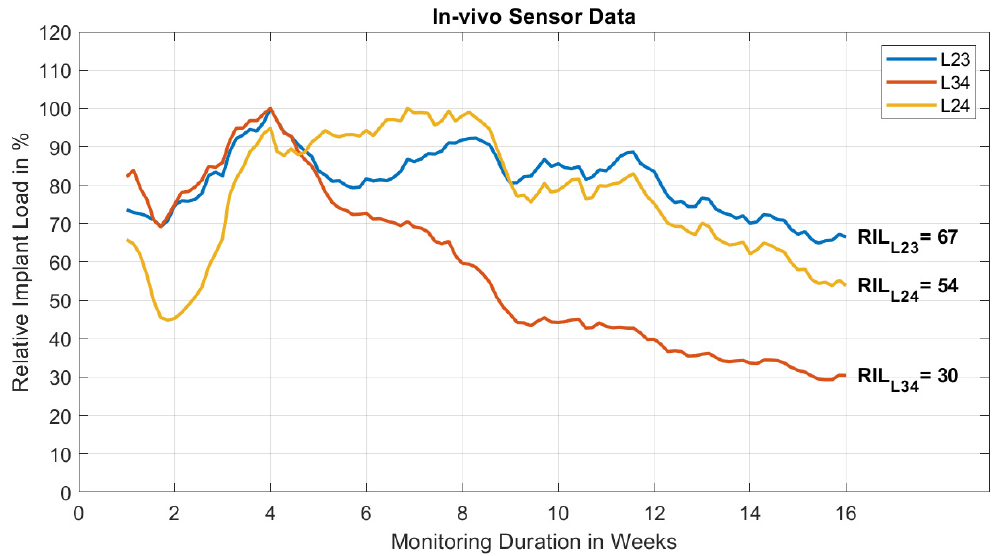
Figure 4. Recorded relative implant load (RIL) over time for the three sensors.